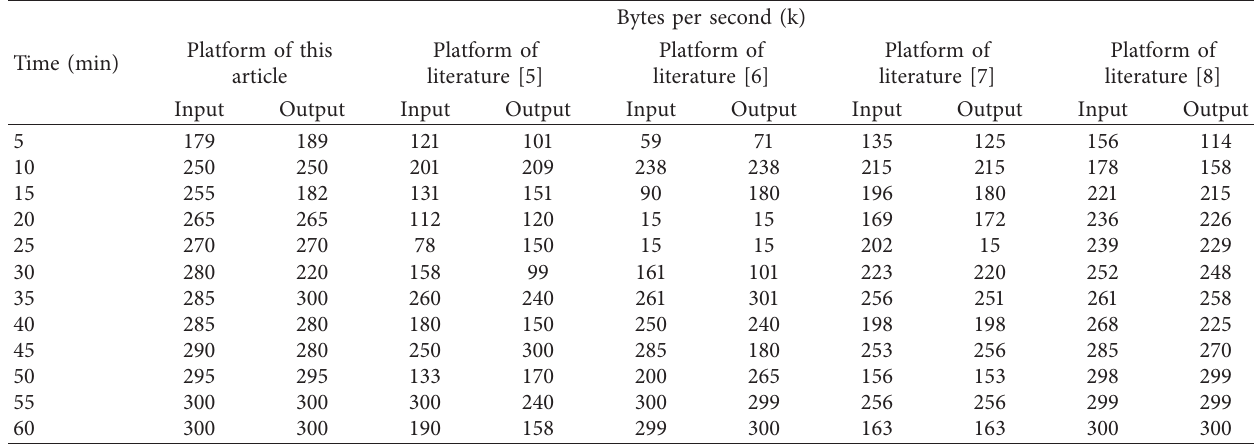
Table 2: Data acquisition results of all platforms.